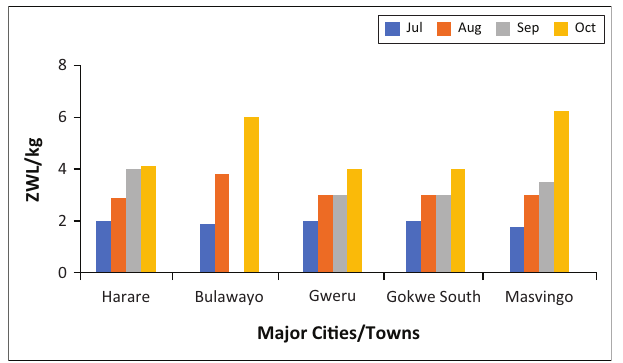
FIGURE 9: Sources of support as a percentage of sampled households.